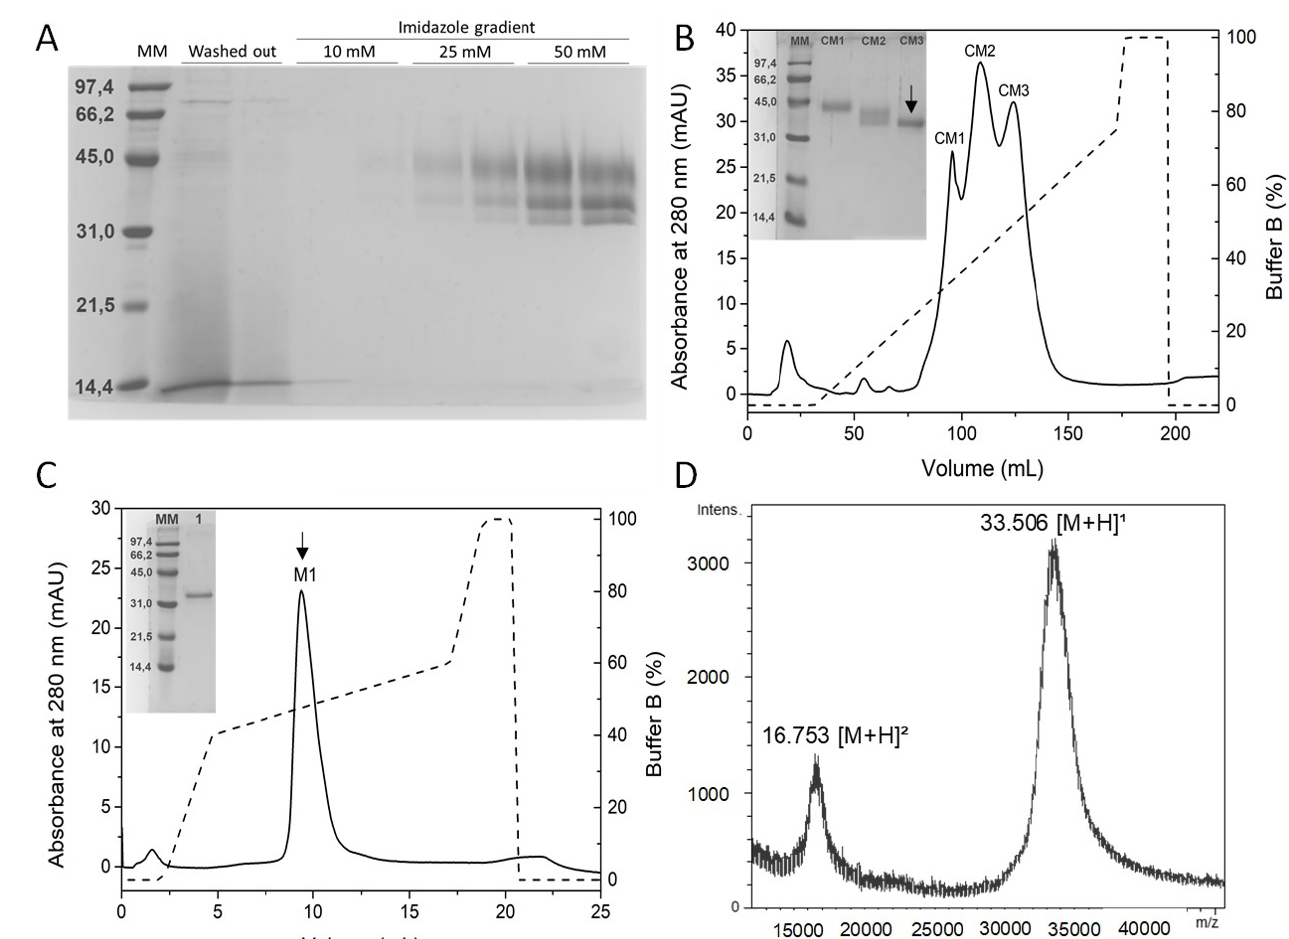
Figure 1. Expression and purification of rCollinein-1. A: 13,5% SDS-PAGE of fractions eluted from the first purification step of rCollinein-1 on a Ni 2+ - Agarose column. Fractions were eluted with a segmented gradient from 10 mM to 250 mM imidazole. MM, molecular marker; washed out, proteins eluted from the column with buffer without imidazole. The recombinant protein is indicated by the arrow. Fractions eluted with 25 and 50 mM imidazole were collected and submitted to a second purification step. B: Second purification step on an ion exchange column (CMC52). Elution was performed in a segmented gradient of sodium acetate buffer, pH 5.0 (50 mM to 1 M). The fractions (CM1, CM2 and CM3) were analyzed by 13.5% SDS-PAGE (inserted panel). C: Chromatographic profile of fraction CM3 on ion exchange chromatography (Mini S ® column), using the same buffer described for CMC52. Insert: 13,5% SDS-PAGE of fraction M1. D: MALDI-TOF analysis of fraction